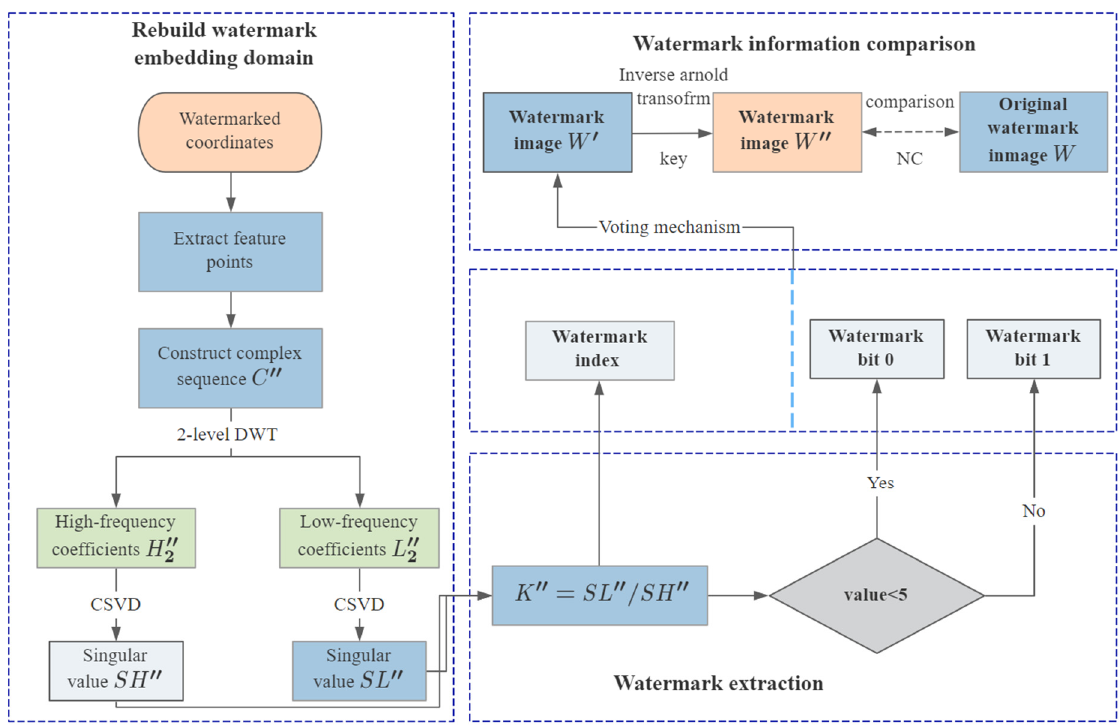
Figure 5. Flow chart of watermark extraction algorithm. Step 1: the watermark index and mapped bit ( bit m ) are obtained from the ratio K . The real watermark bit ( bit r ) is calculated by Equation (29).